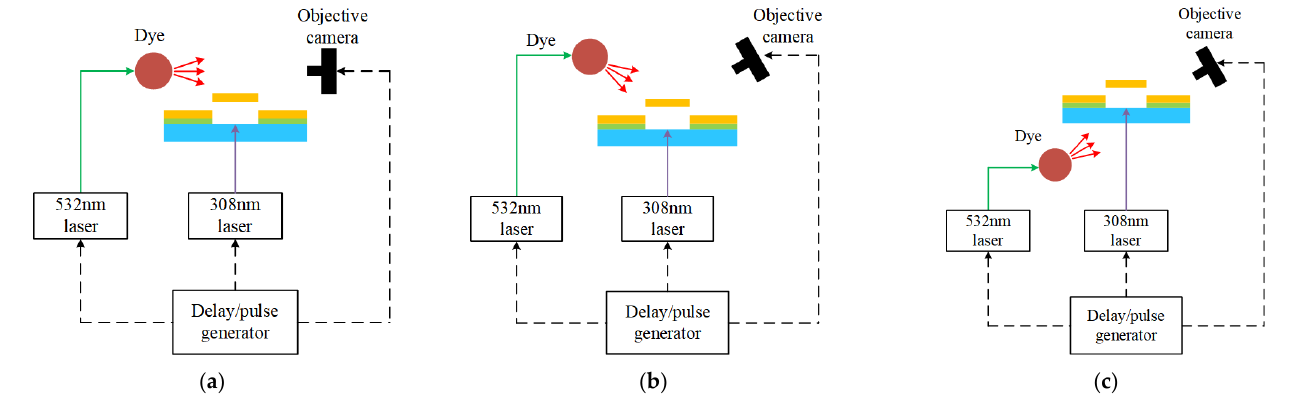
Figure 21. Schematics of the three different shadowgraphy modes: ( a ) surface-parallel mode; ( b ) reflectivity mode; ( c ) transmission mode [86].